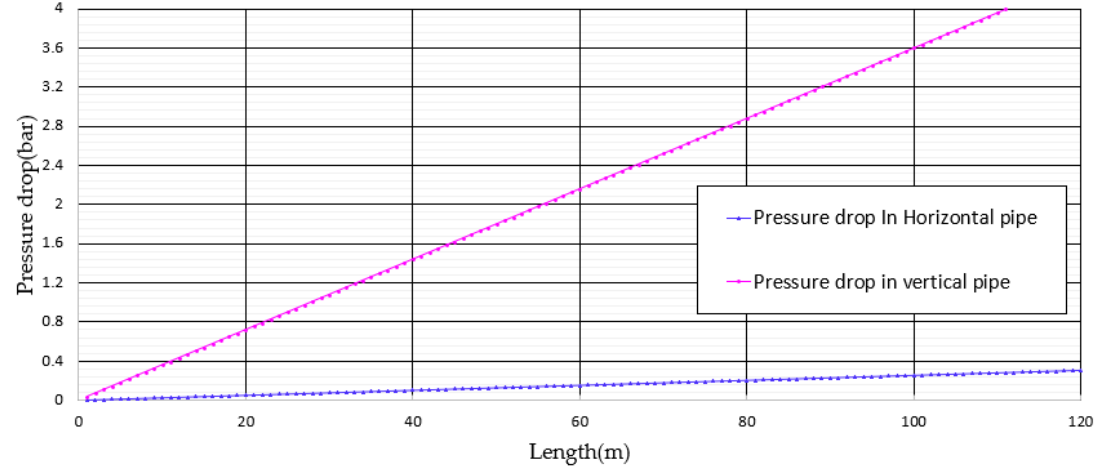
Table 6. Case simulation parameters with test scenario